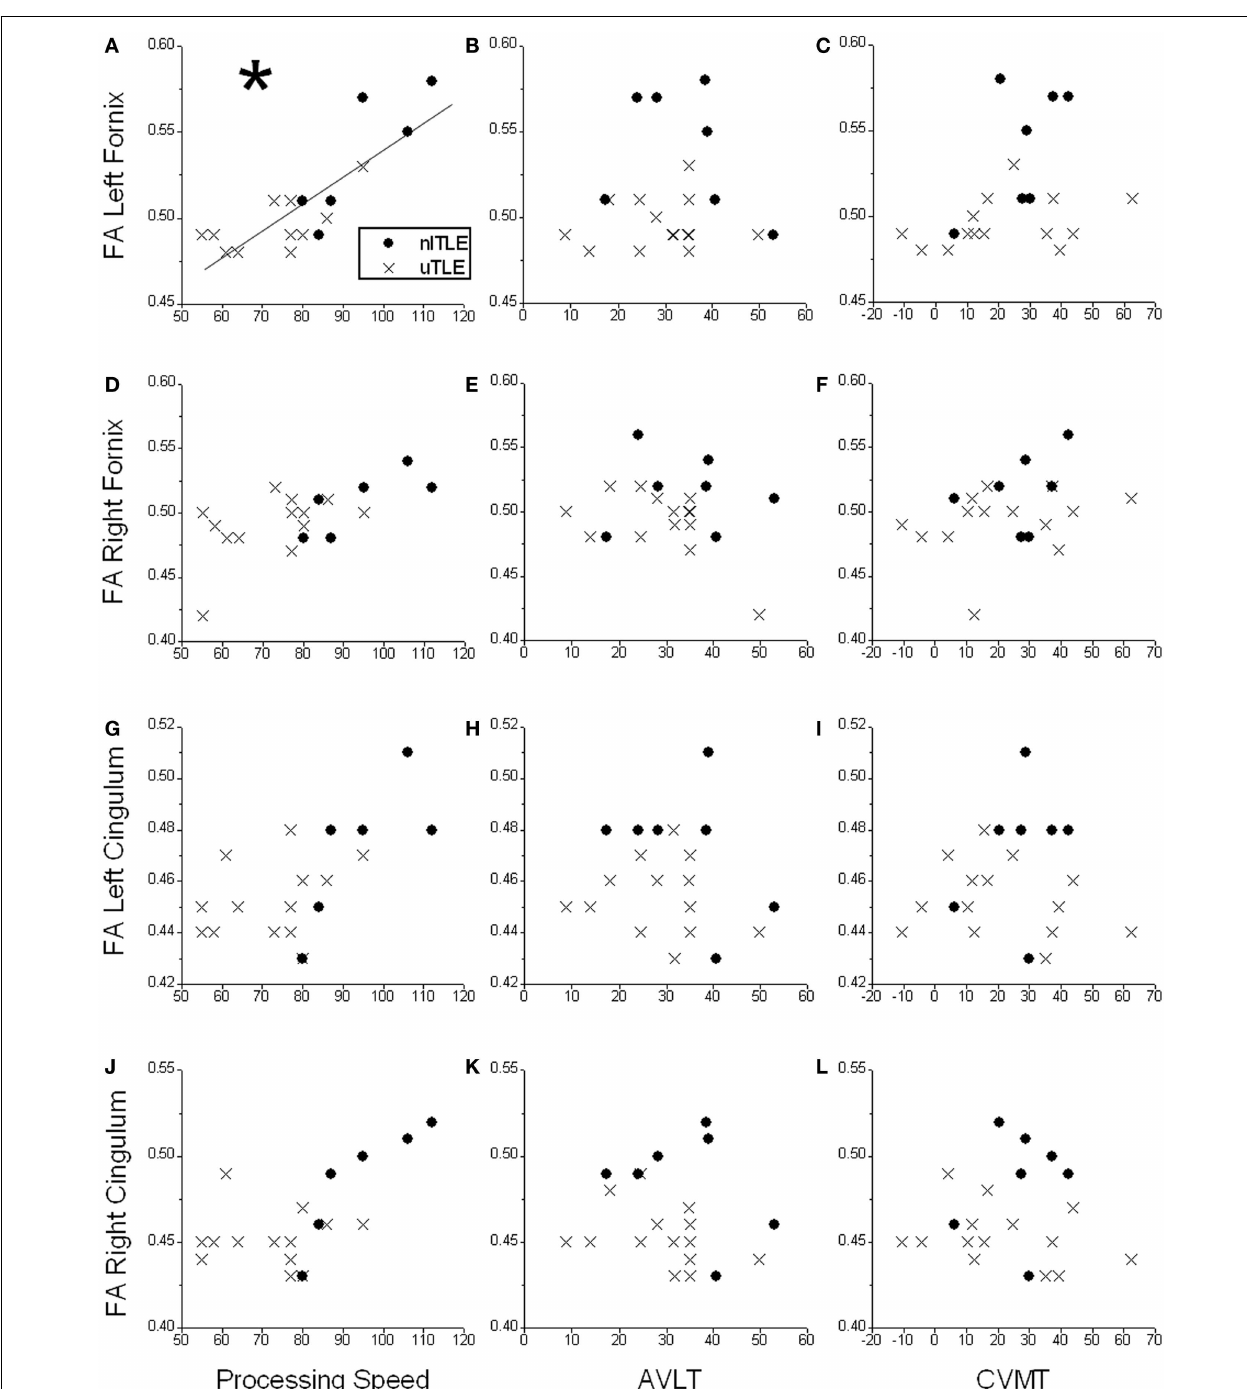
FIGURE 1 | Scatter plots displaying correlations of neuropsychological test scores [Processing Speed Index,AuditoryVerbal LearningTest (AVLT), and ContinuousVisual MemoryTest (CVMT)] and fractional anisotropy (FA) of the left fornix (A–C), right fornix (D–F), left cingulum (G–I), and right cingulum (J–L) in patients with temporal-lobe epilepsy